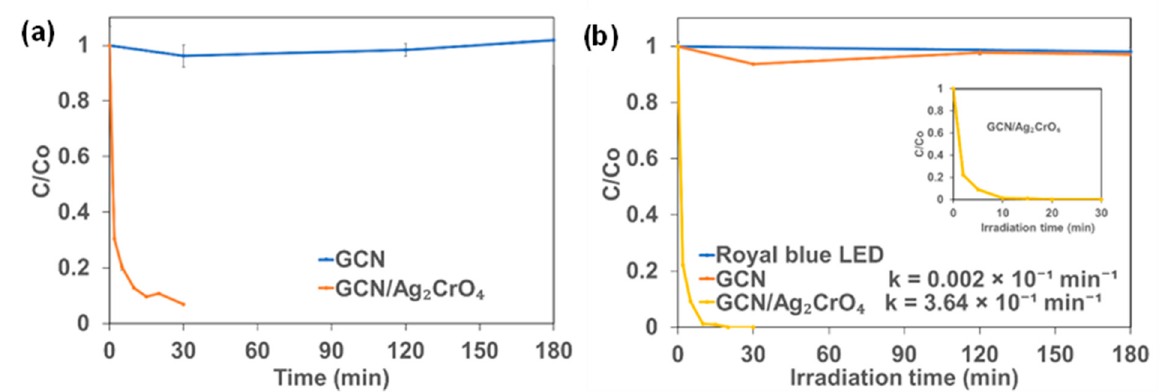
Figure 3. Change in BSA concentration with time: ( a ) Dark experiment and ( b ) Royal blue LED irradiation.